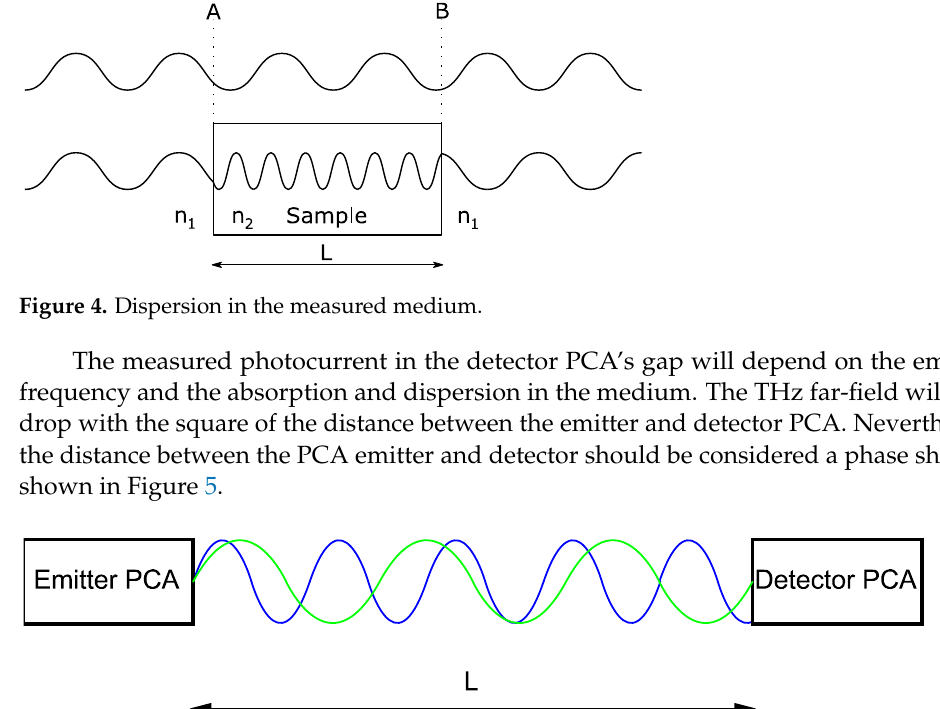
Figure 5. Phase change dependency on the variable frequency at fixed distance L between emitter PCA and detector PCA.